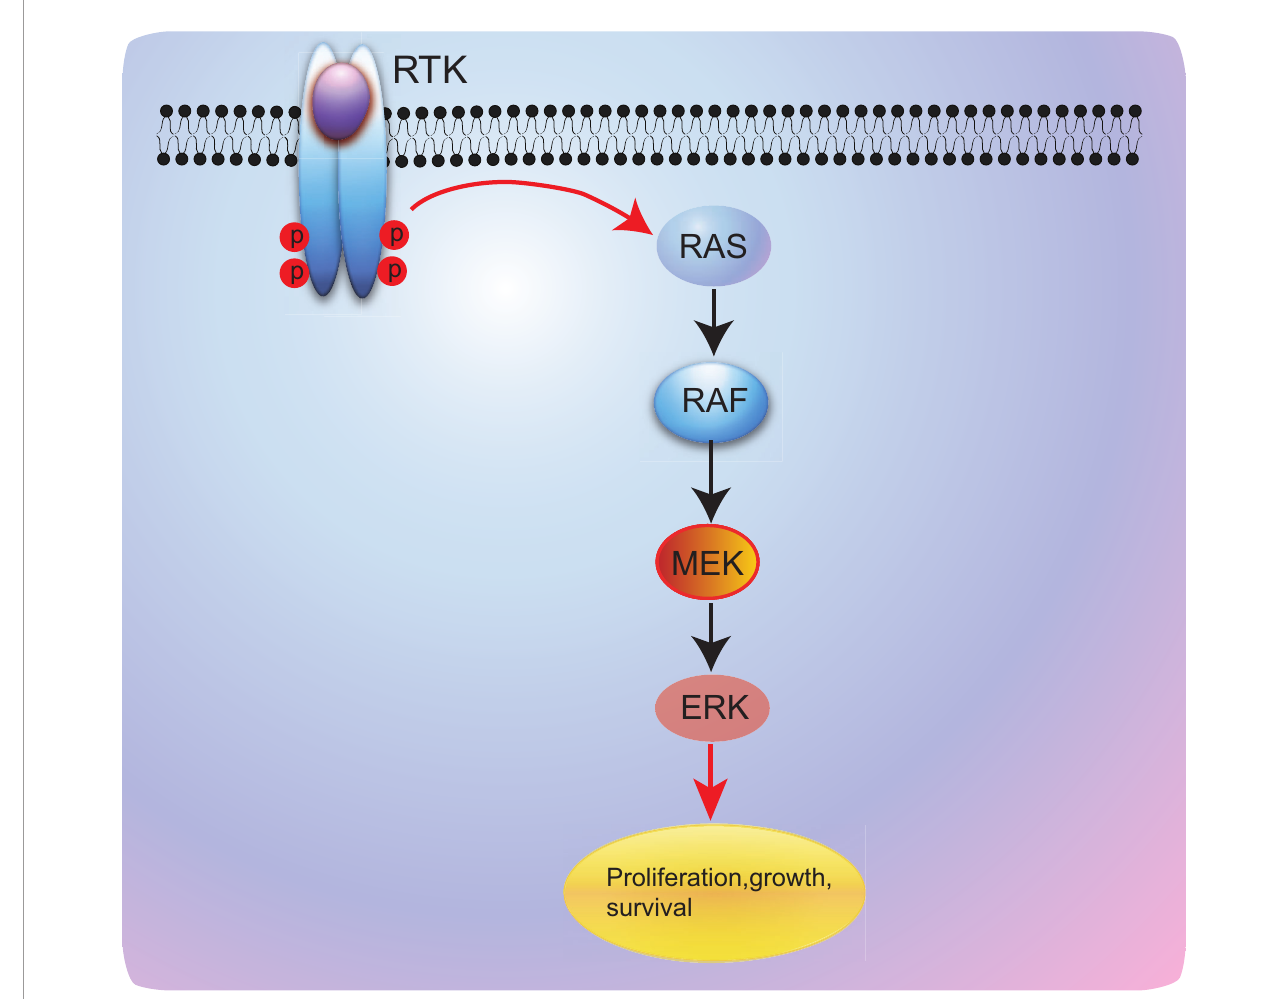
FIGURE 1 | RAS/RAF/MEK/ERK signaling pathway. RTK, receptor tyrosine kinase; RAS, rat sarcoma; RAF, v-raf murine sarcoma viral oncogene; MEK, mitogen- activated protein kinase kinase; ERK, extracellular signal-regulated